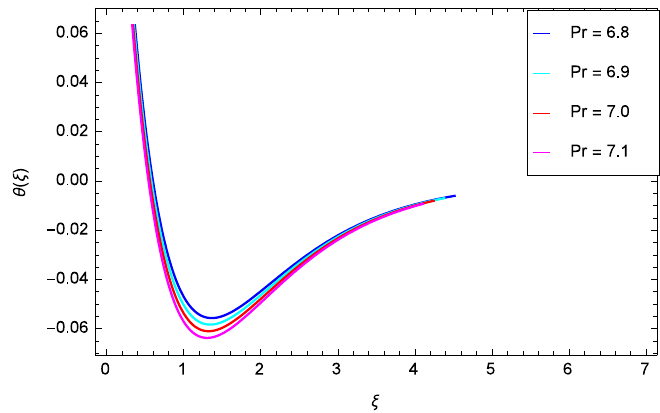
Figure 14. Impact of the Prandtl number Pr on temperature θ ( ζ )